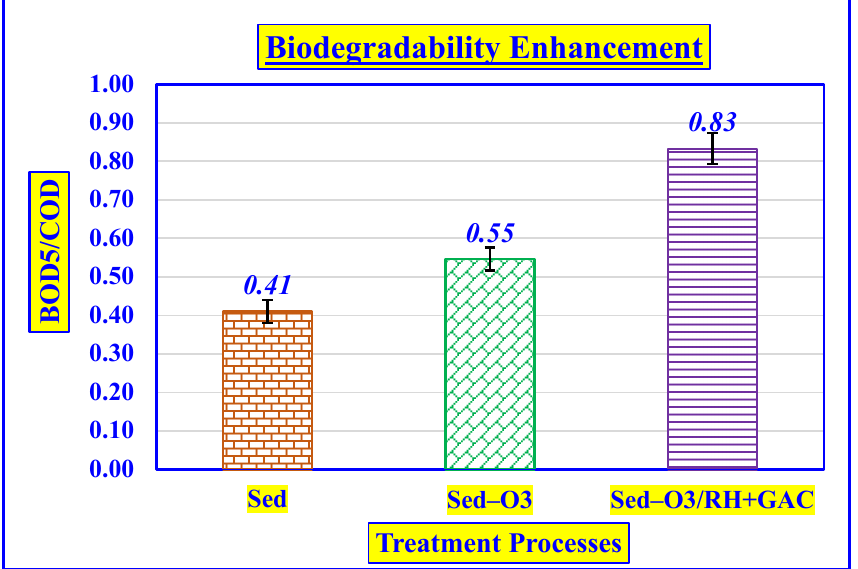
Figure 9. Biodegradability increased by hybrid system (Initial COD = 490 ± 11.5 mg/L; Initial BOD5 = 225 ± 9 mg/L; O 3 = 82.5 ± 2.2 mg/L; peristaltic pump speed = 150 rpm; C.T = 18 min; GAC = 200 g; RH = 200 g; pH = 6.9 ± 0.2; volume = 4 L; T = 25 ± 2 ◦ C).